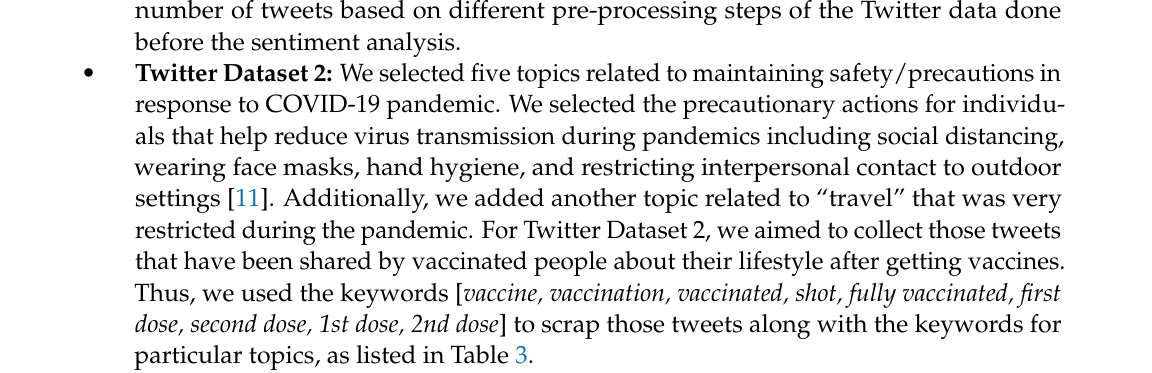
Table 3. Twitter Dataset 2: Tweets on healthy lifestyle used in our experimental evaluation.